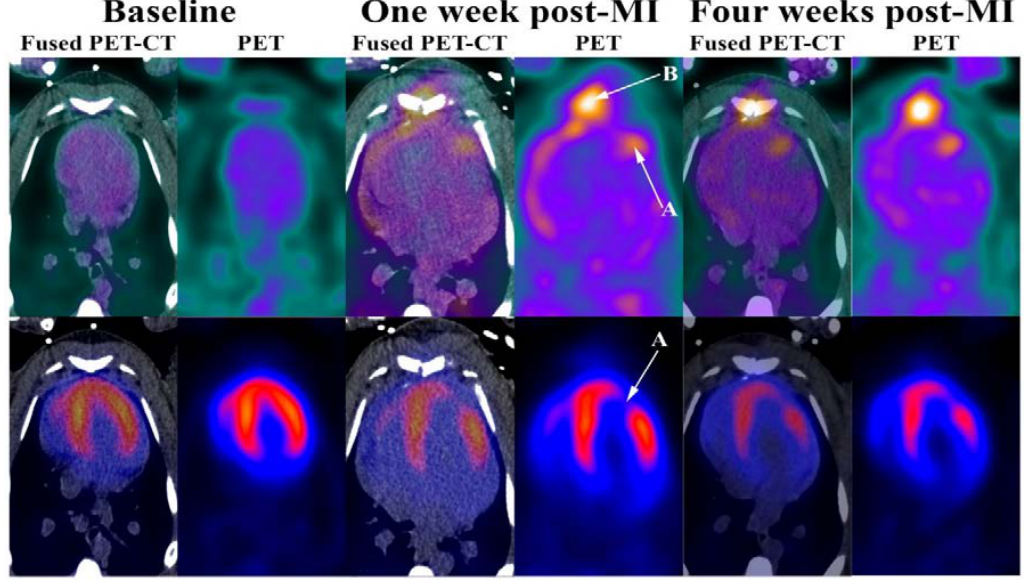
Figure 2. Modified from [12]. RGD ( Top ) and 82 Rb stress ( Bottom ) PET at baseline, one week and one month after induced myocardial infarction. ( A ) Myocardial infarction; ( B ) Sternotomy.